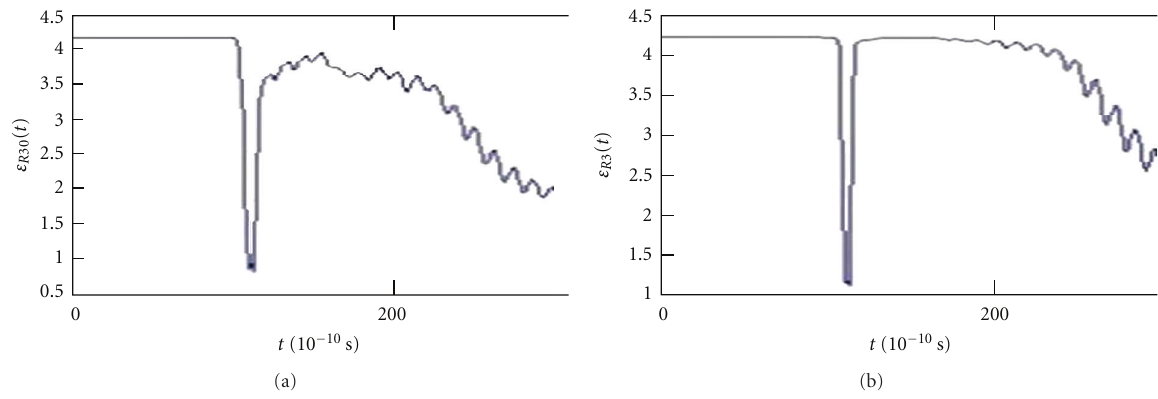
Figure 4: Renyi entropy for (cid:8) M = 10 and two di ff erent values of β . (a) β = 30, (b) β =